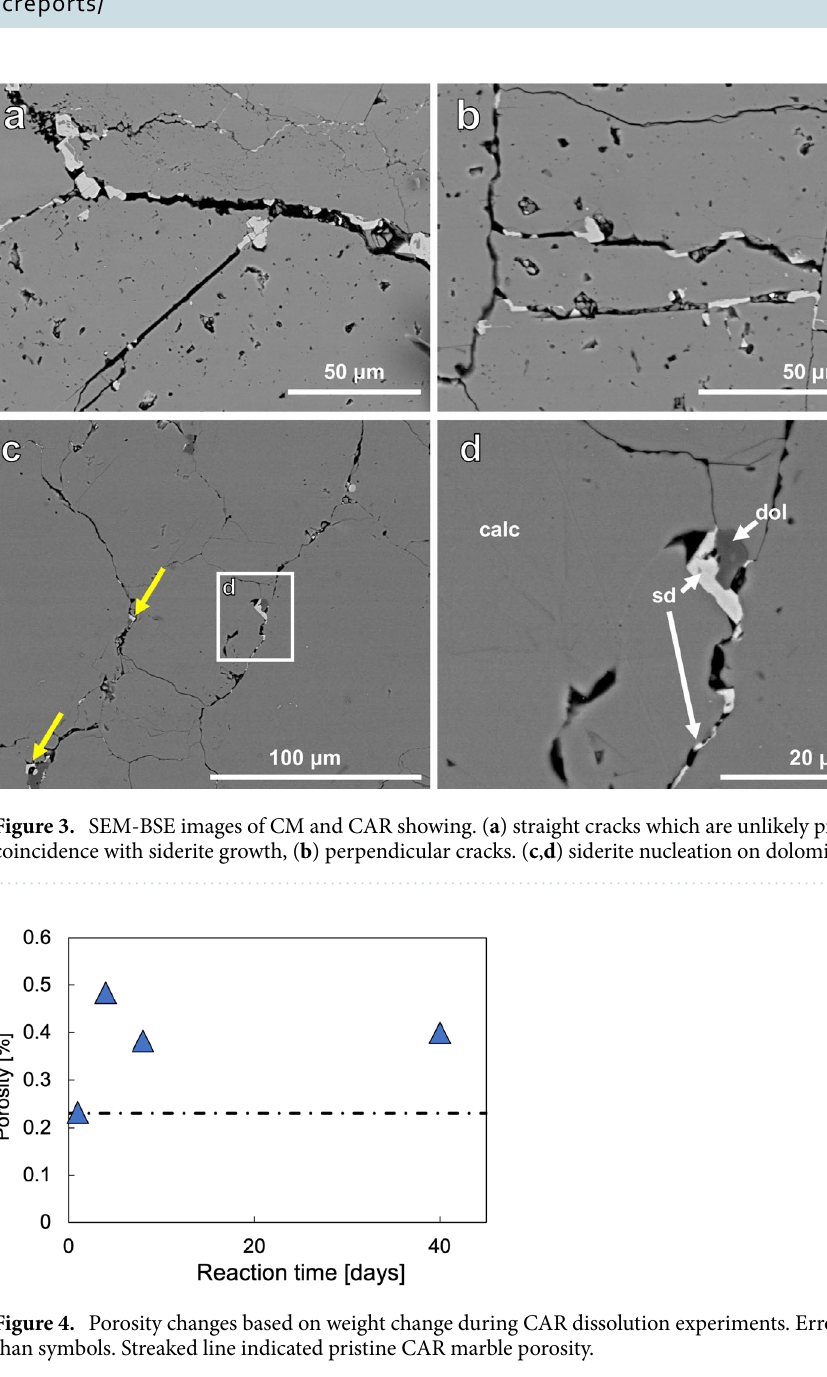
Quantification of porosity changes by (U)SAXS and (U)SANS.